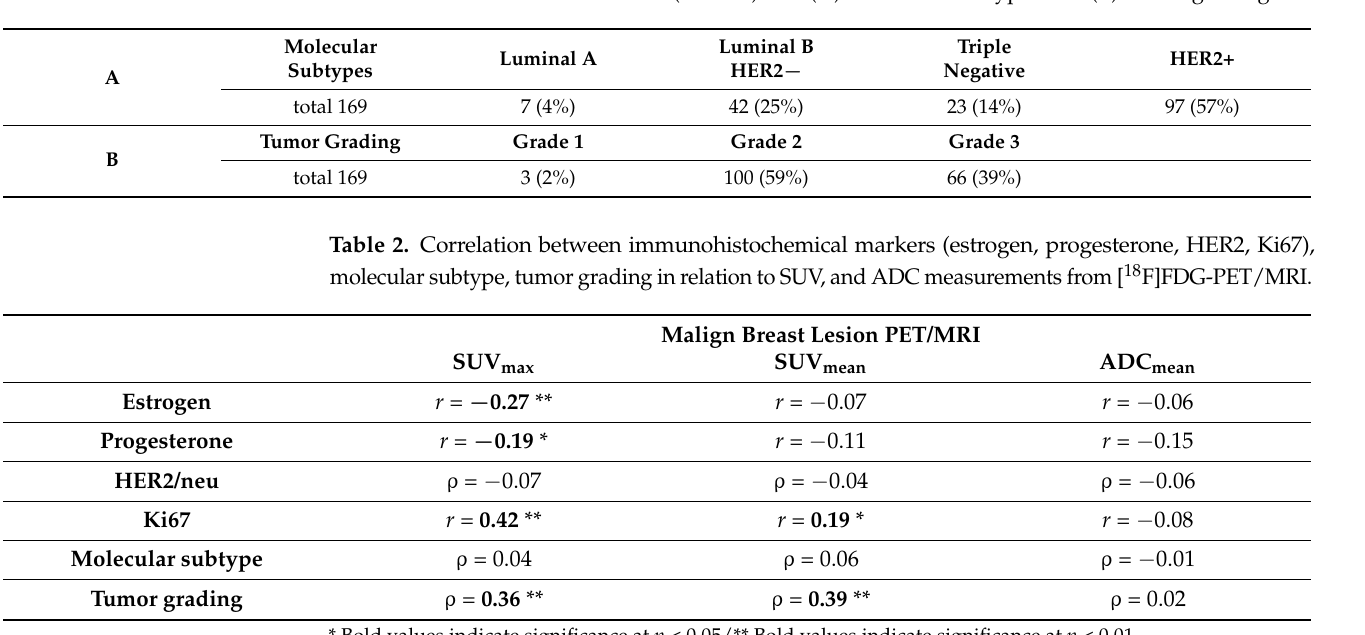
Table 1. Distribution of the cohort (n = 169) into (A) molecular subtypes and (B) tumor grading.